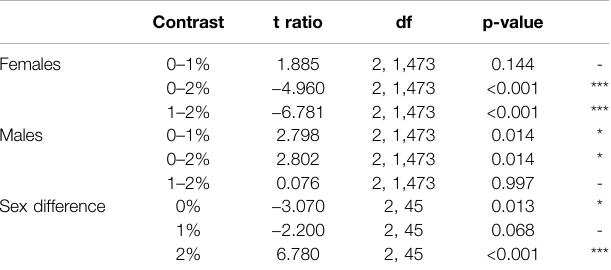
TABLE 3 | Post-hoc pair-wise comparisons of the slope in Distance moved over time, per Sex/Dose group.